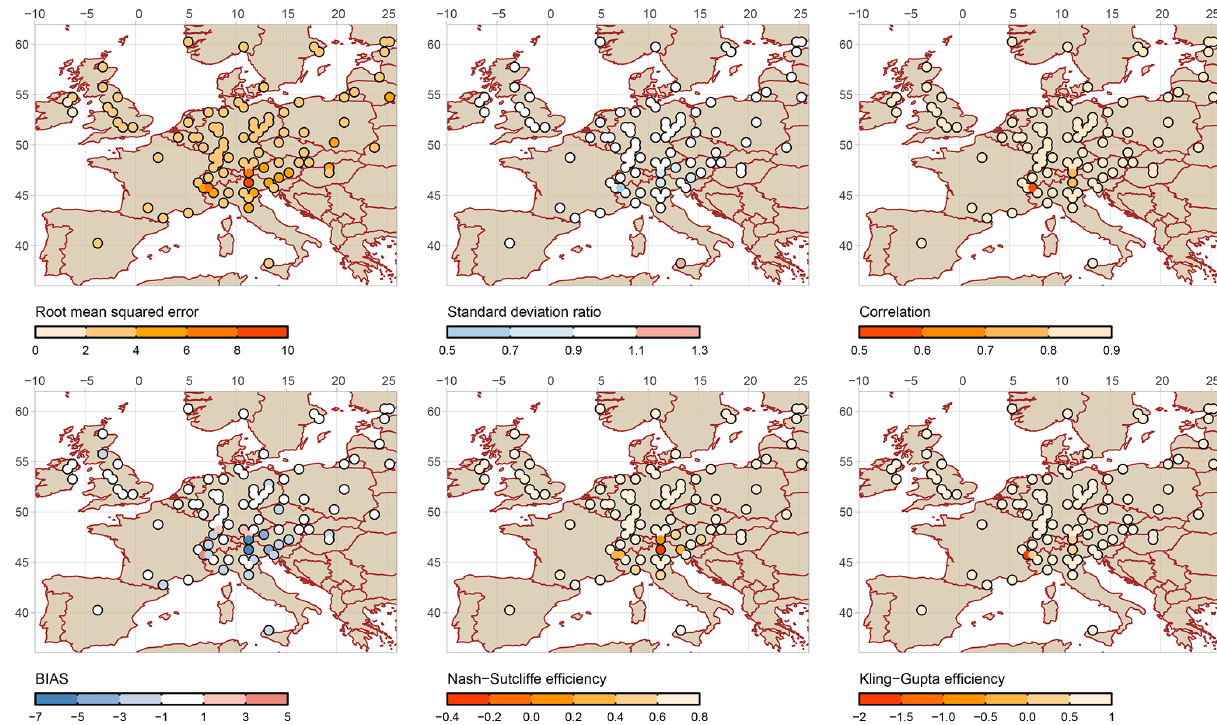
Figure 4. Validation of reconstructed temperature (Luterbacher et al., 2004) against GHCN observations.